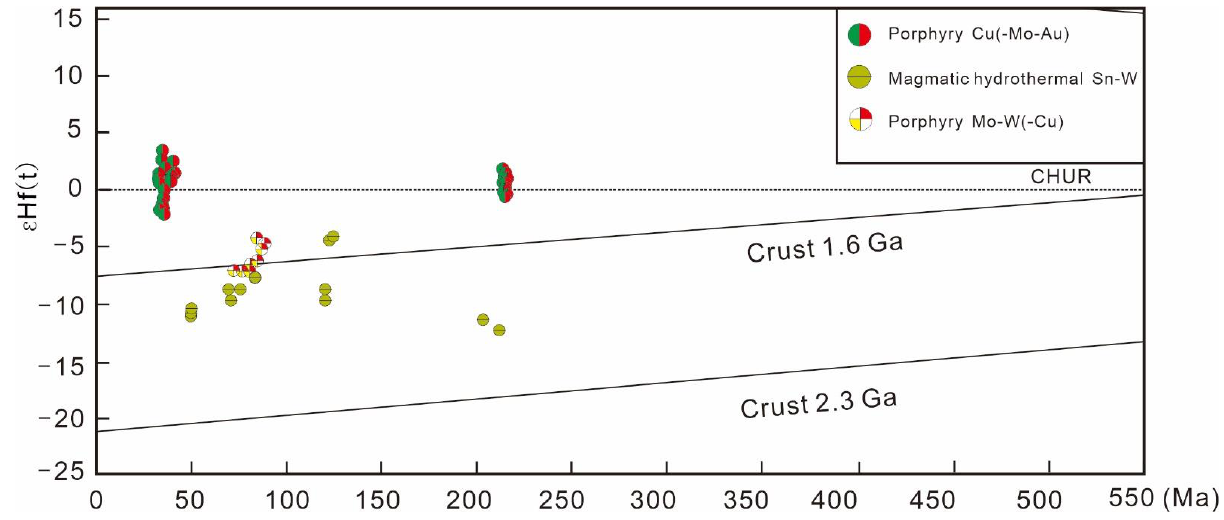
Figure 4. Plots of median εHf(t) versus U -Pb ages of magmatic zircons.